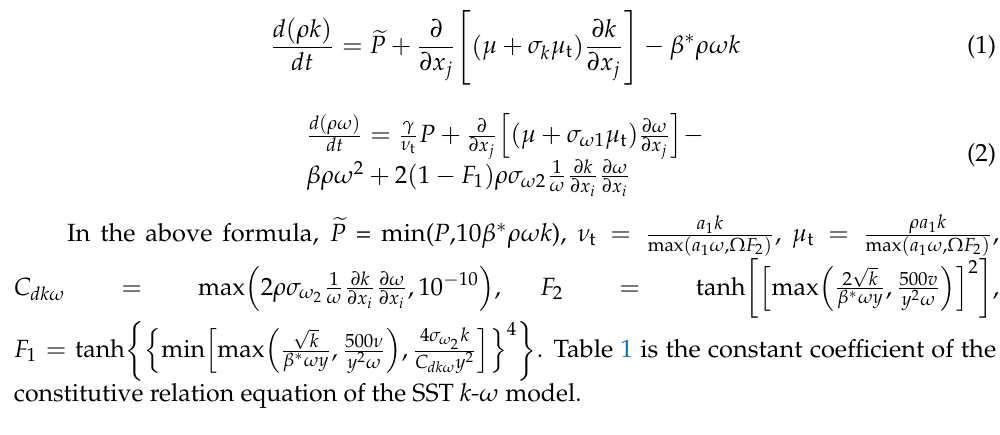
Table 1. Constant coefficient of the constitutive equation of the SST model. Inner Layer Model Constant Outer Model